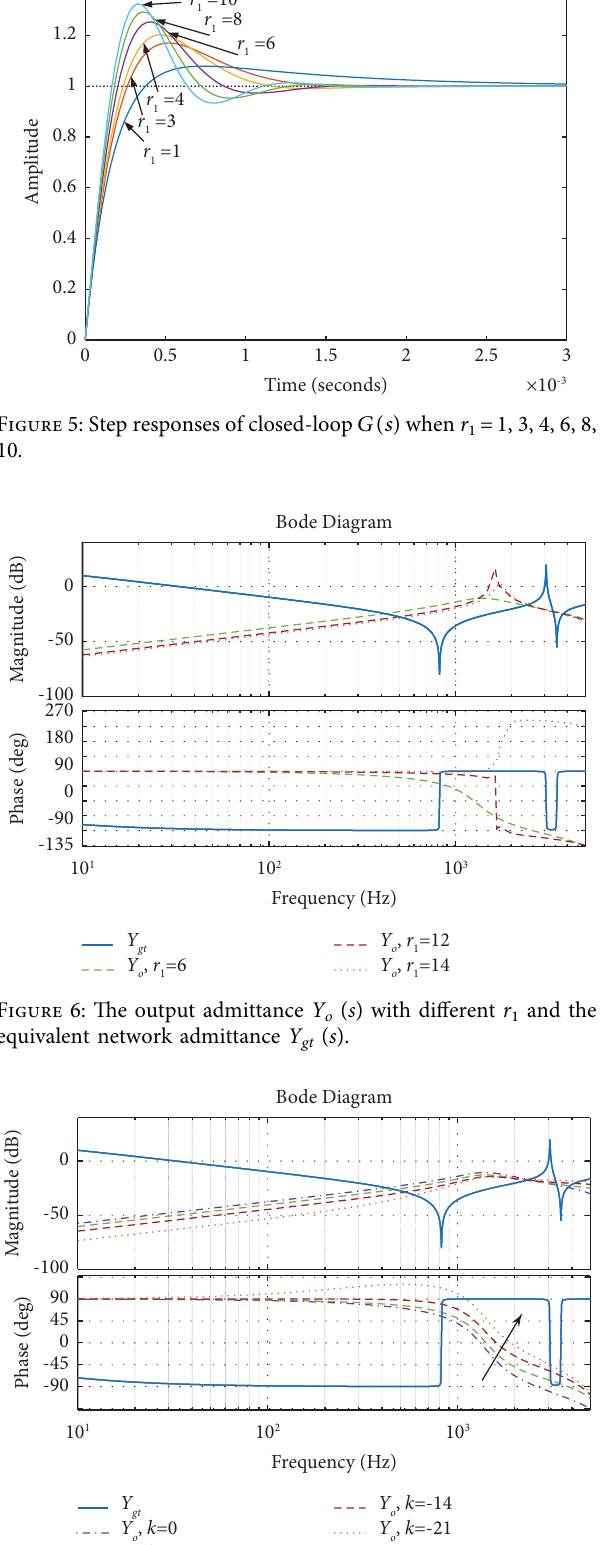
Figure 7: Te output admittance Y o ( s ) with diferent proportional feedback coefcients and the equivalent network admittance Y gt ( s